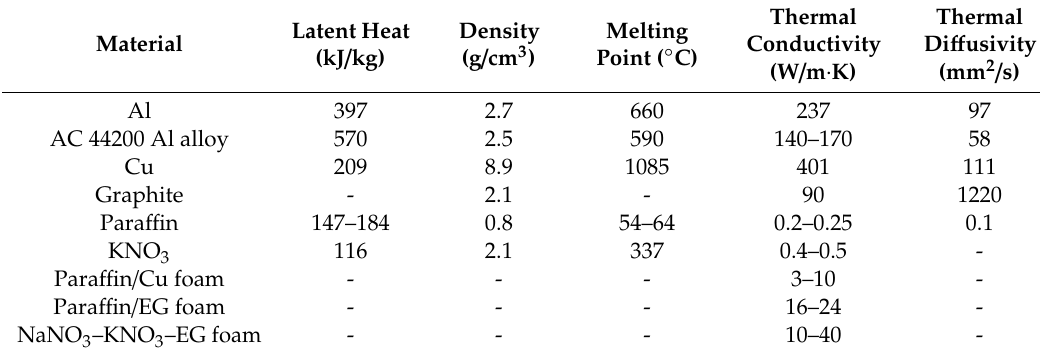
Table 1. Selection of exemplary physical and heat transfer properties of metals, pure and enhanced (composite) phase change materials (PCMs)